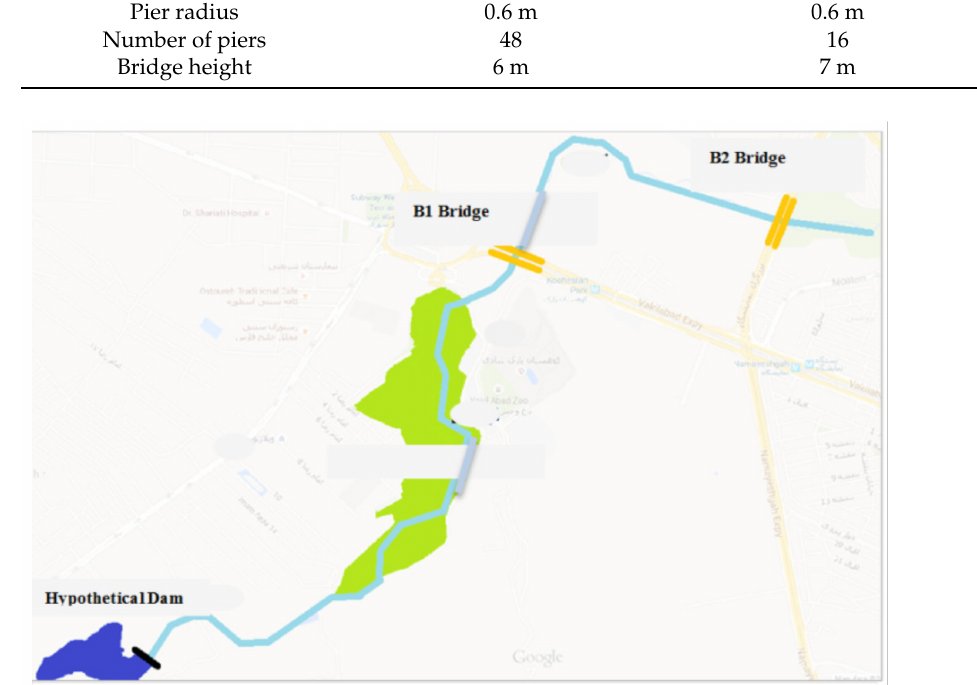
Figure 12. River plan and land